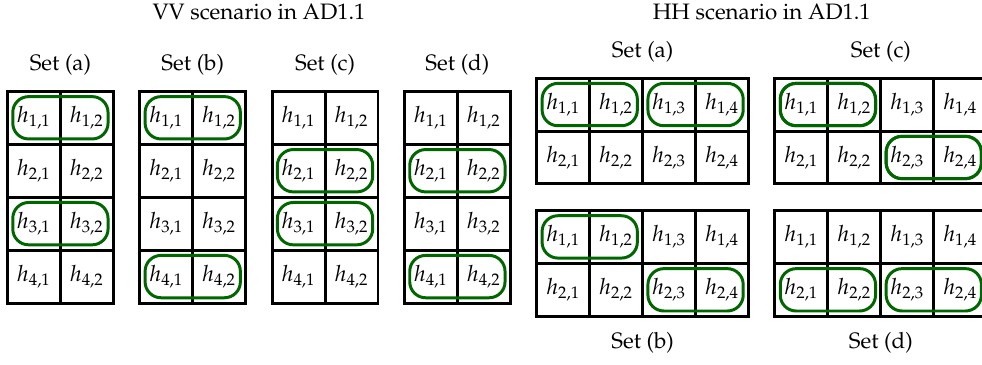
Figure 5. Four cases with maximum values of elements h i , j in VV and HH scenarios in